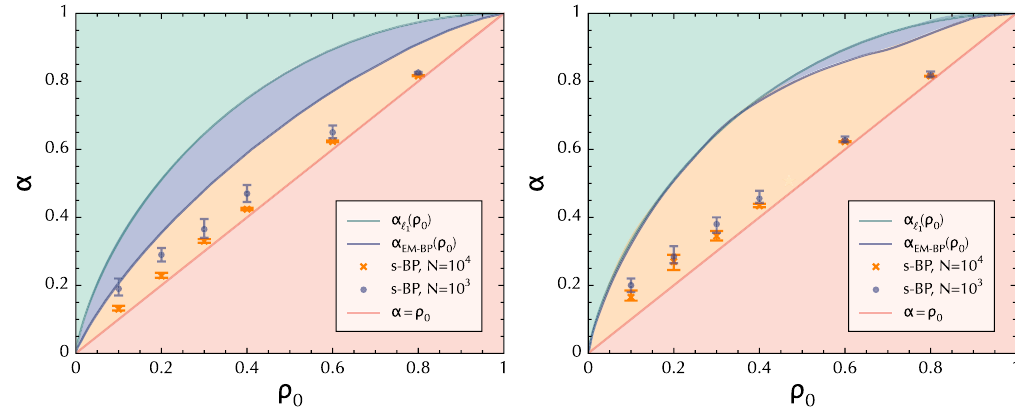
N nonzero FIG. 2. Phase diagrams for compressed-sensing reconstruction for two different signal distributions. On the left, the (cid:2) 0 components of the signal are independent Gaussian random variables with zero mean and unit variance. On the right, they are independent (cid:7) 1 variables. The measurement rate is (cid:1) ¼ M=N . On both sides, we show, from top to bottom: (a) The phase transition (cid:1) for ‘ reconstruction [5,11,12] (which does not depend on the signal distribution). (b) The phase transition (cid:1) for EM-BP ‘ 1 1 EM - BP reconstruction based for both sides on the probabilistic model with Gaussian (cid:4) . (c) The data points which are numerical-reconstruction thresholds obtained with the s-BP procedure with L ¼ 20 . The point gives the value of (cid:1) where exact reconstruction was obtained in 50% of the tested samples; the top of the error bar corresponds to a success rate of 90%; the bottom of the bar to a success of 10%. The shrinking of the error bar with increasing N gives numerical support to the existence of the phase transition that we have studied optimal line, and they move closer to it analytically. These empirical reconstruction thresholds of s-BP are quite close to the (cid:1) ¼ (cid:2) 0 that is the with increasing N . The parameters used in these numerical experiments are detailed in Appendix E. (d) The line (cid:1) ¼ (cid:2) 0 . An alternative presentation of the same data using the convention of theoretical reconstruction limit for signals with continuous (cid:4) 0 Donoho and Tanner [5] is shown in Appendix